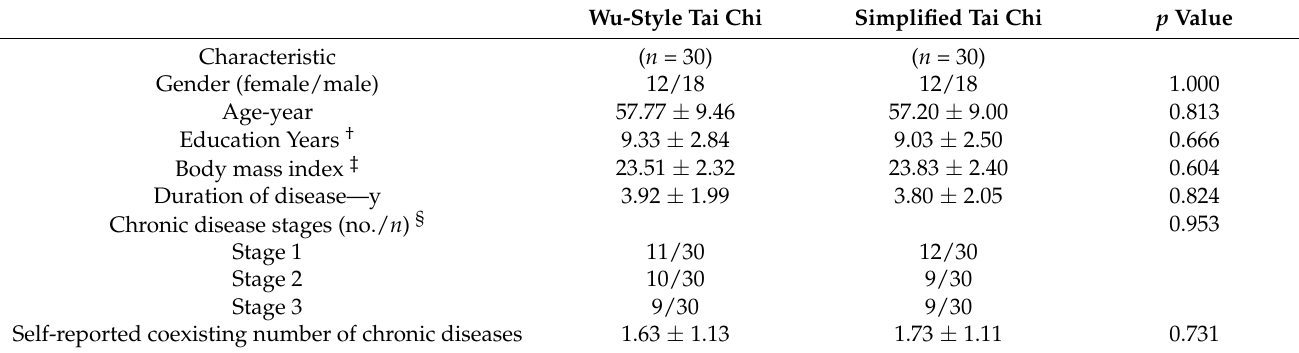
Table 1. Demographic and clinical characteristics of the study participants at baseline